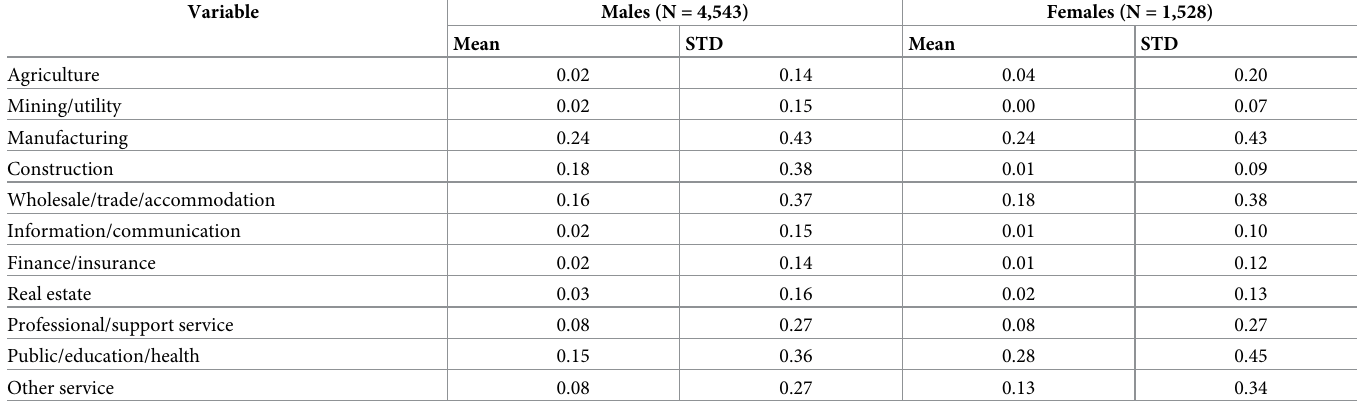
: s 2 ¼ 0 through the likelihood ratio test, we con- 0 v